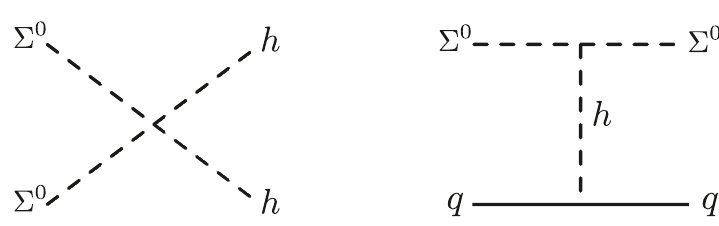
Figure 1 . Examples of contributions from the Higgs portal coupling to the DM annihilation (left) and spin-independent (right) cross section. The variable q represents the SM quarks.